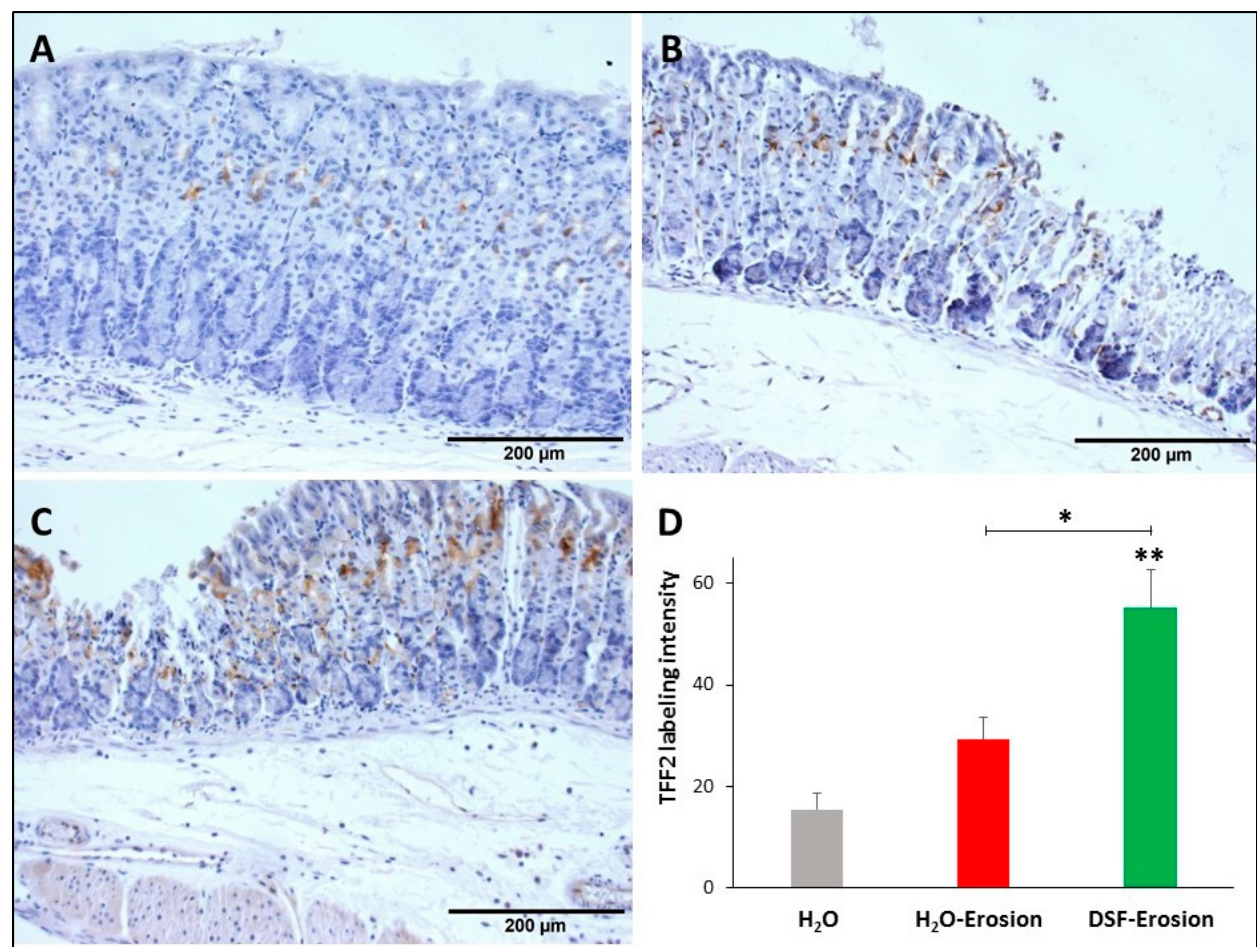
Figure 8. TFF2 immunolabeling in the gastric mucosae of H 2 O control ( A ), erosion-induced ( B ) and DSF-pretreated ( C ) mice. The tissue sections were counterstained with hematoxylin. Brownish TFF2-labeled cells are seen in the middle of the gastric mucosae. Labeled cells are more apparent in DSF-pretreated tissues than in control and erosion-induced tissues. ( D ) Quantification of TFF2 labeling intensity per field is presented from three mice in each group as mean ± SE. * p < 0.05 and ** p < 0.01; scale bar = 200 µm.